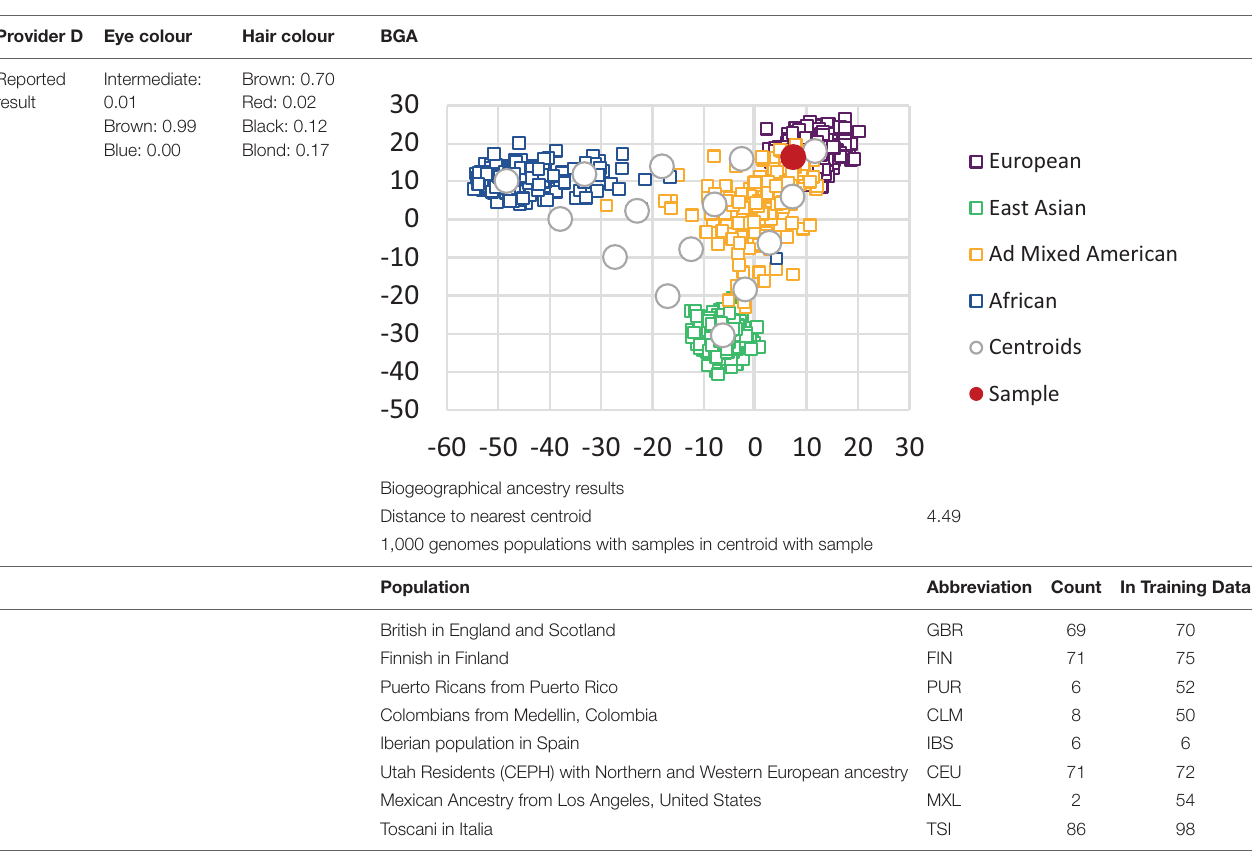
TABLE 7 | Provider D reporting style for eye colour, hair colour, and BGA